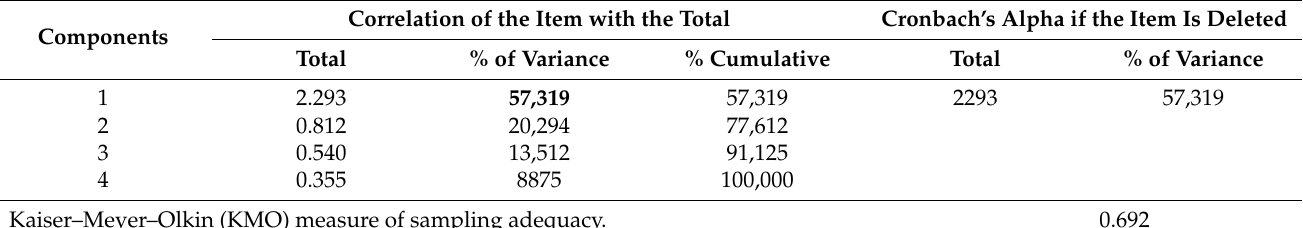
Table 7. Factorial Analysis of the “Interdepartmental communication”.